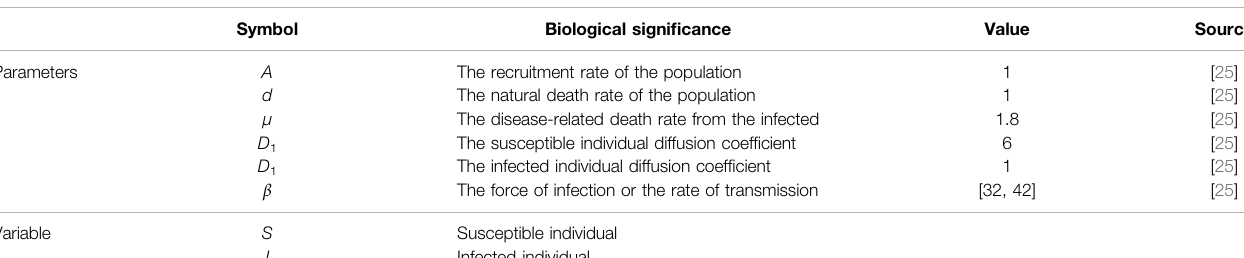
TABLE 3 | Biological signi fi cance and value of all parameters in the model